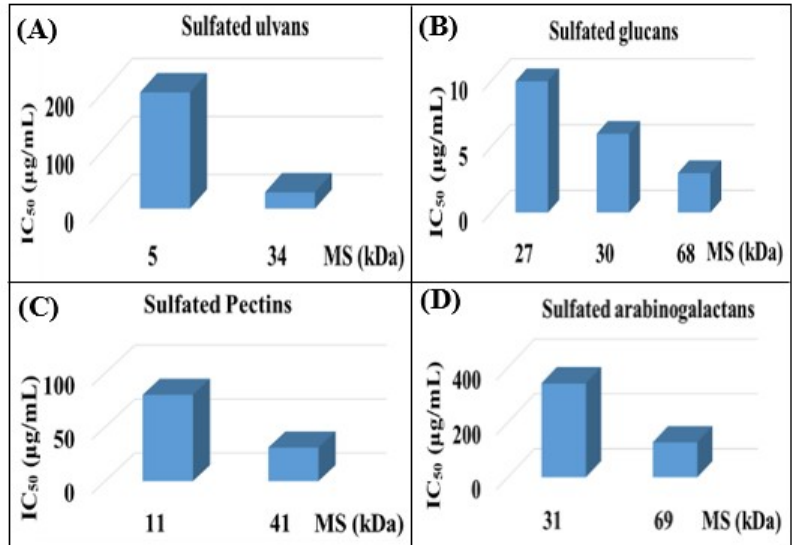
Figure 2. Comparison of antiviral activity of sulfated ( A ) ulvans against HSV-1 [45], ( B ) glucans against HCMV [47], ( C ) pectins against HSV-1 [259] and ( D ) arabinogalactans against HSV-1 [44], having different molecular masses (MSs). Antiviral activity was performed by plaque reduction assay in HEp-2 cells (human larynx epithelial cells carcinoma, ATCC CCL-23) ( A , C ), in Vero cells (ATCC CCL-81) ( D ) and by GFP-based replication assay in primary human fibroblasts ( B ). The sulfated polysaccharide’s degree of sulfation (DS) (i.e., number of sulfate groups